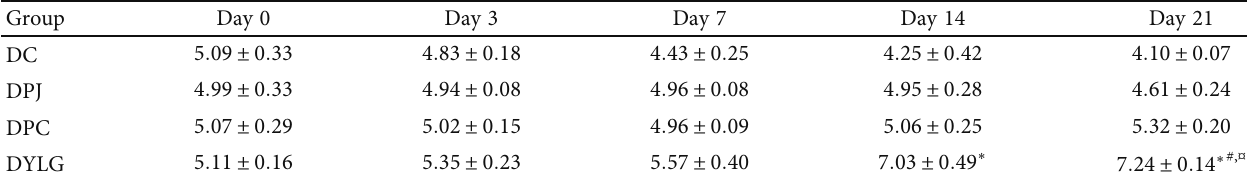
Table 4: The blood C-peptide levels (ng/ml) in T2DM rats on days 0, 3, 7, 14, and 21 ( n = 24 per group). Group Day 0